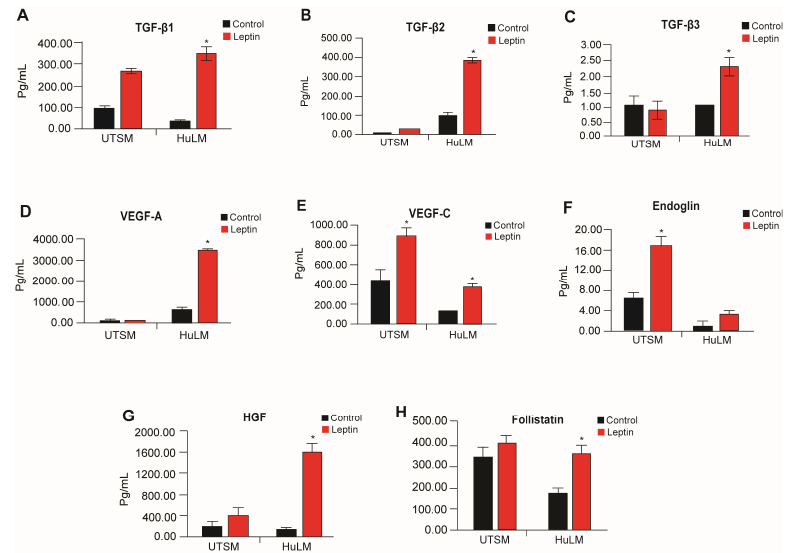
Figure 5. Effect of leptin treatment in fibrosis and angiogenesis factors secretion in human immortalized leiomyoma and myometrium cells. Immortalized human leiomyoma cells and myometrium were treated with 100 ng/mL leptin for 48 h. After the incubation time, the collected media were used to measure the secretion levels of ( A ) TGF- β 1, ( B ) TGF- β 2, ( C ) TGF- β 3, ( D ) VEGF-A, ( E ) VEGF-C, ( F ) Endoglin, ( G ) HGF, and ( H ) Follistatin. The mean ± standard error of the mean (SEM) was determined from three independent experiments. *, p < 0.05 vs. control.